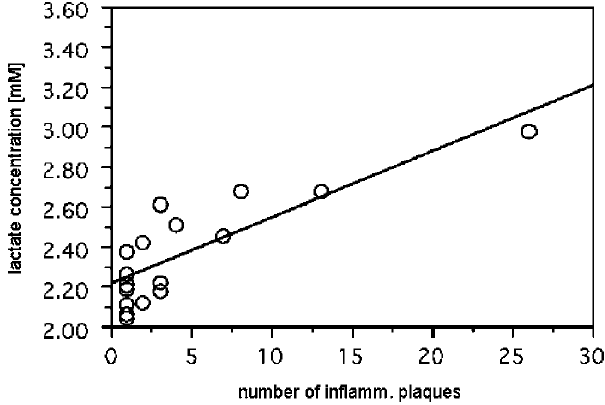
Figure 4. Lactate concentration [mM] in CSF of CIS patients with inflammatory plaques vs. number of inflammatory plaques, with linear fit.